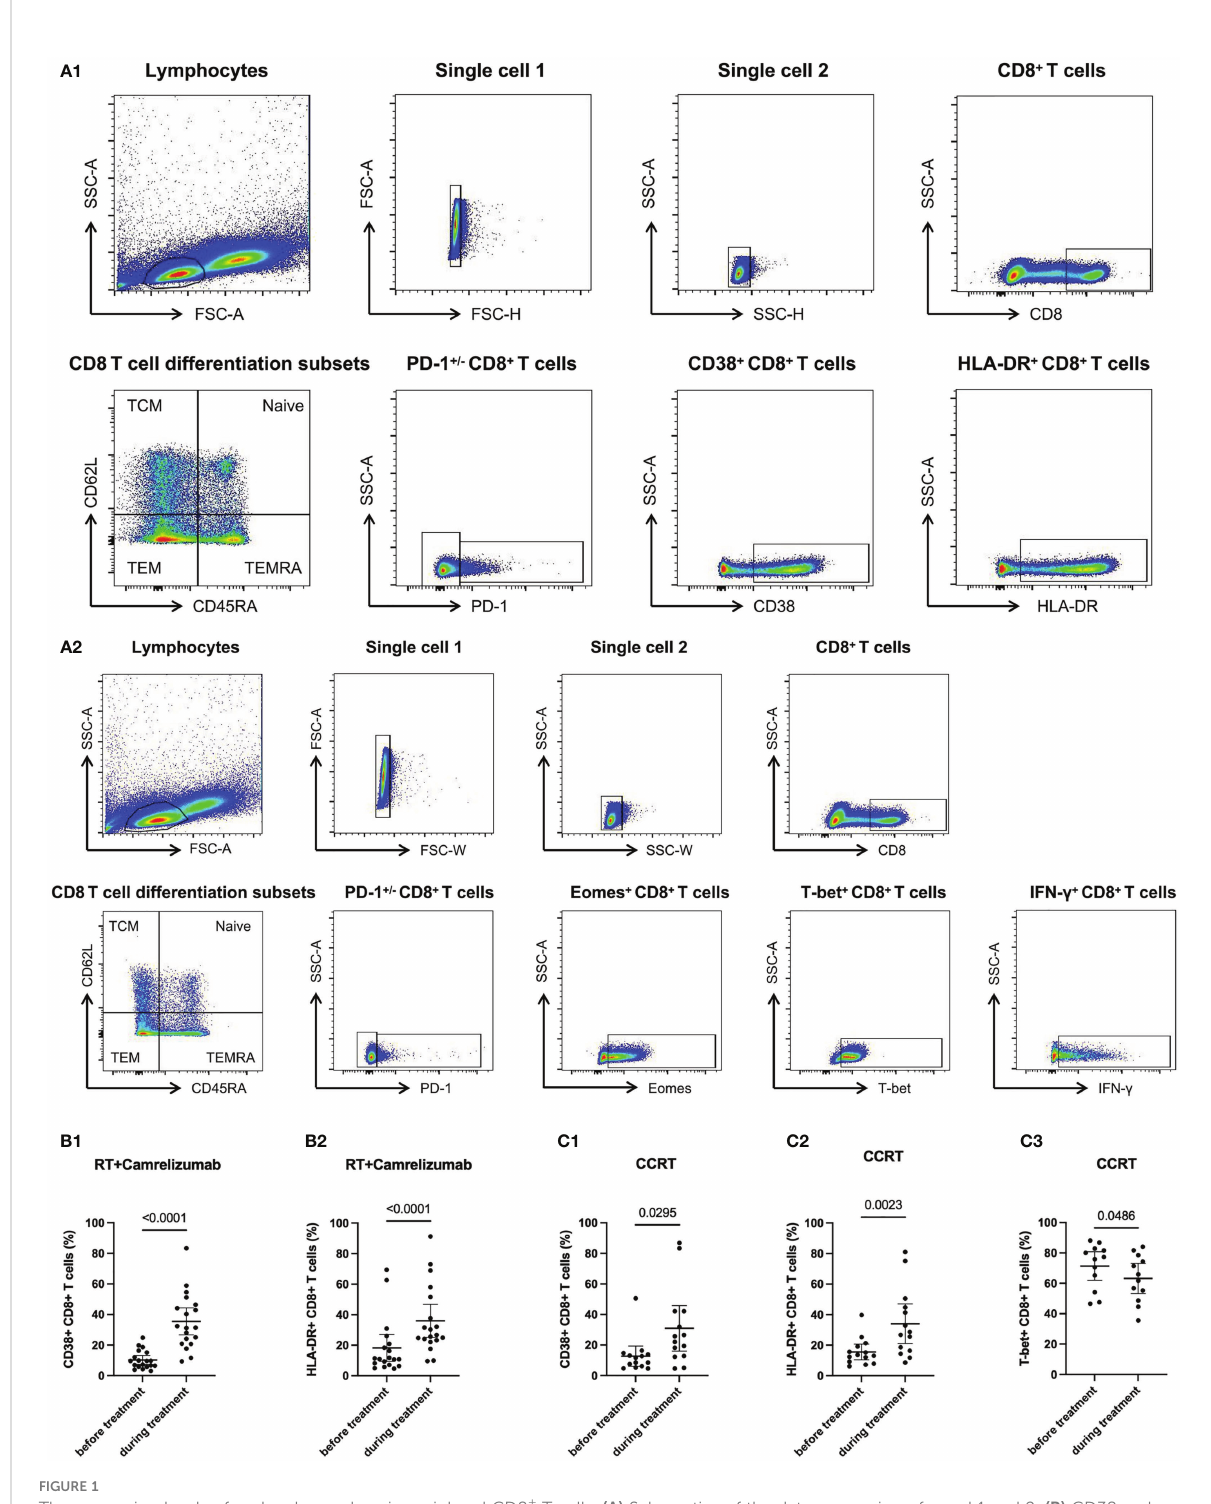
FIGURE 1 The expression levels of molecular markers in peripheral CD8 + T cells. (A) Schematics of the data processing of panel 1 and 2. (B) CD38 and HLA-DR expressions on CD8 + T cells in RT plus camrelizumab group. (C) CD38, HLA-DR and T-bet expressions in CD8 + T cells in CCRT